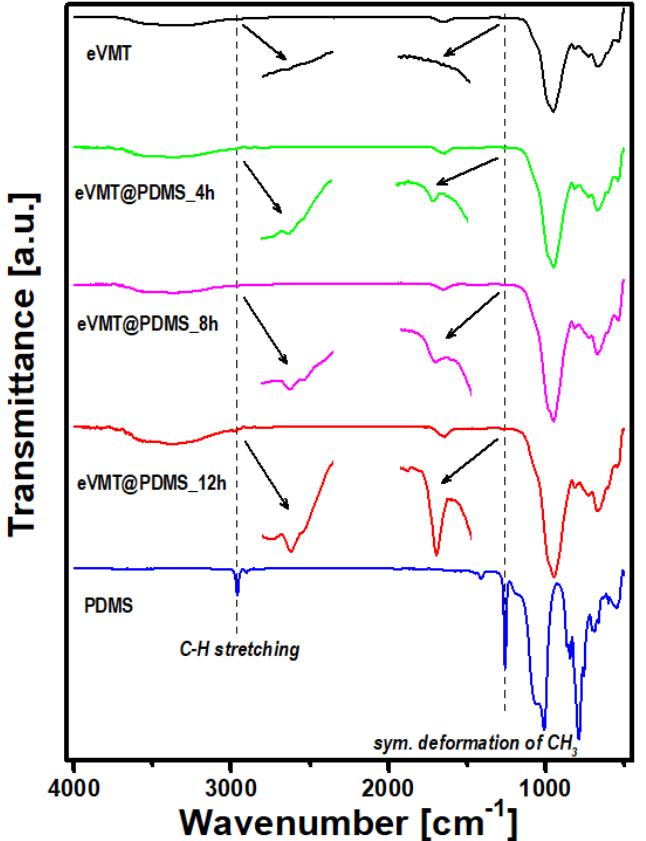
Figure 2. FTIR spectra of eVMT, PDMS, and three eVMT@PDMS samples prepared with the three different deposition times of 4, 8 and 12 h.